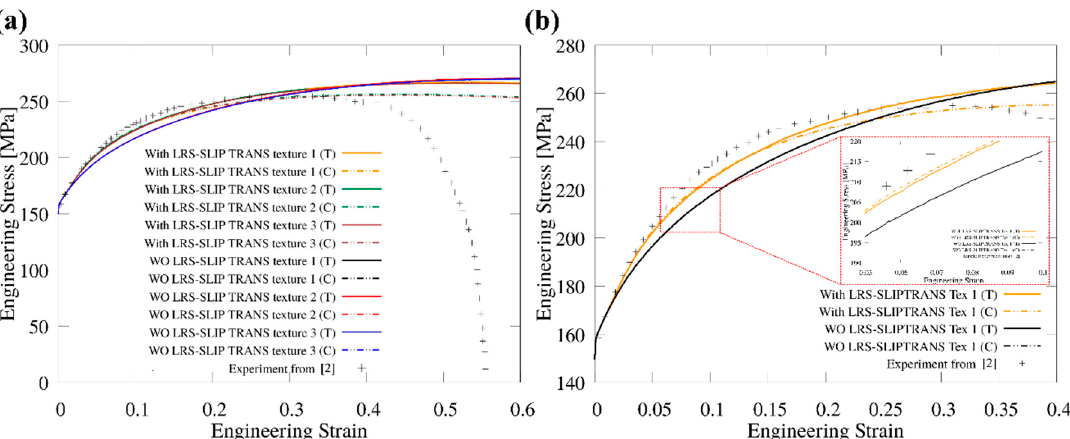
Figure 4. Predicted stress-strain curves of IF steel specimens with homogeneous structures. Results are shown for three initial textures. ( a ) Without (WO) and with back-stress (LRS) and slip transmission (SLIP TRANS) included; ( b ) Comparison of simulation results with and without LRS and SLIP TRANS. T denotes tension; C denotes compression.